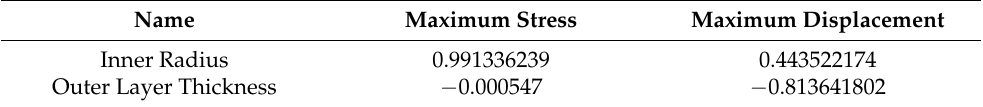
Table 2. Correlation table of first model.